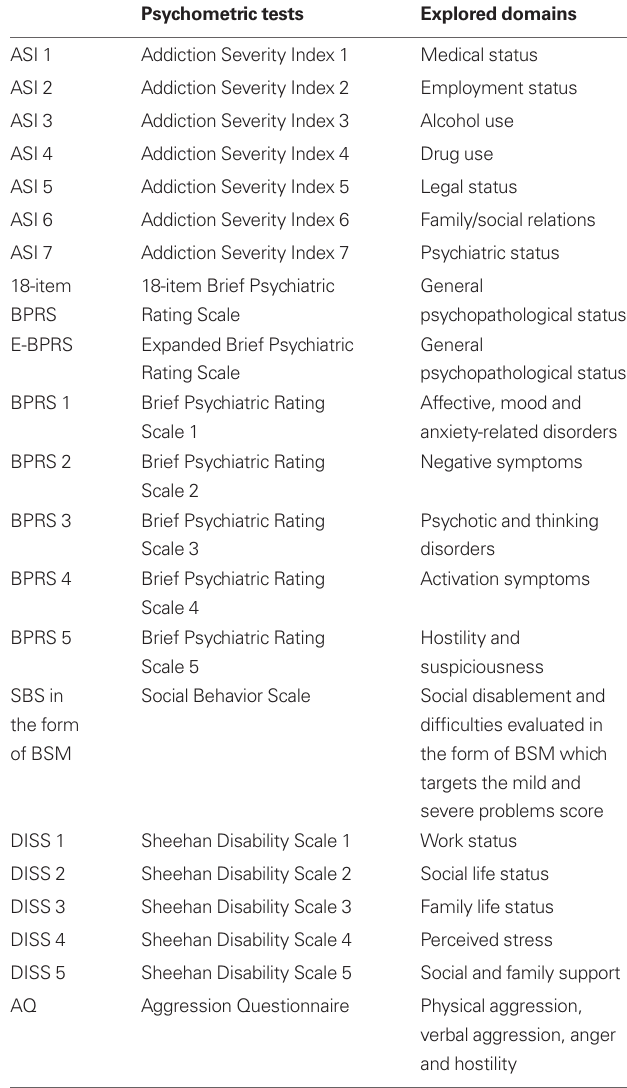
Table 2 | Psychometric tests and their explored